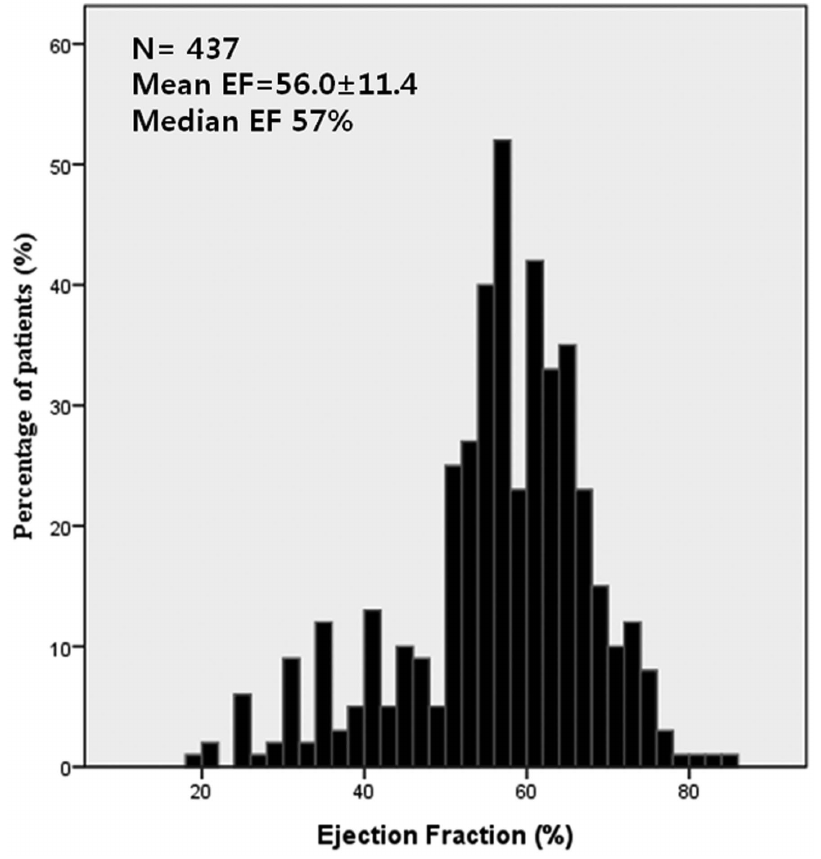
Figure 2. Distribution of EF in included CES patients. Abbreviations: EF:Ejection fraction, CES: Cardioembolic stroke.